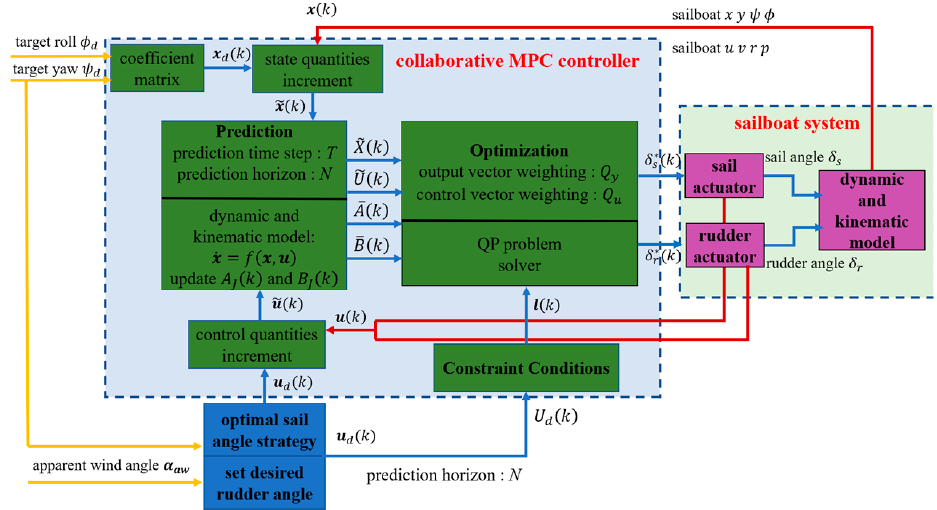
Figure 2. The controller design process diagram.